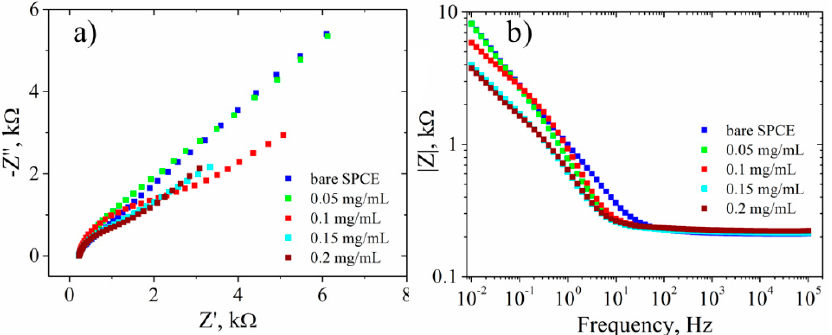
Figure 9. EIS characterization: ( a ) Nyquist plot; ( b ) EIS Bode plot—impedance modulus. Characterizations were recorded in 1 mM [Fe(CN) 6 ] 3 − /4 − , 0.1 M KCl, for bare SPCE (blue) and RGO-SPCEs obtained using different concentrations of GO dispersions 0.05 mg/mL (green), 0.1 mg/mL (red), 0.15 mg/mL (cyan), and 0.2 mg/mL (dark red).